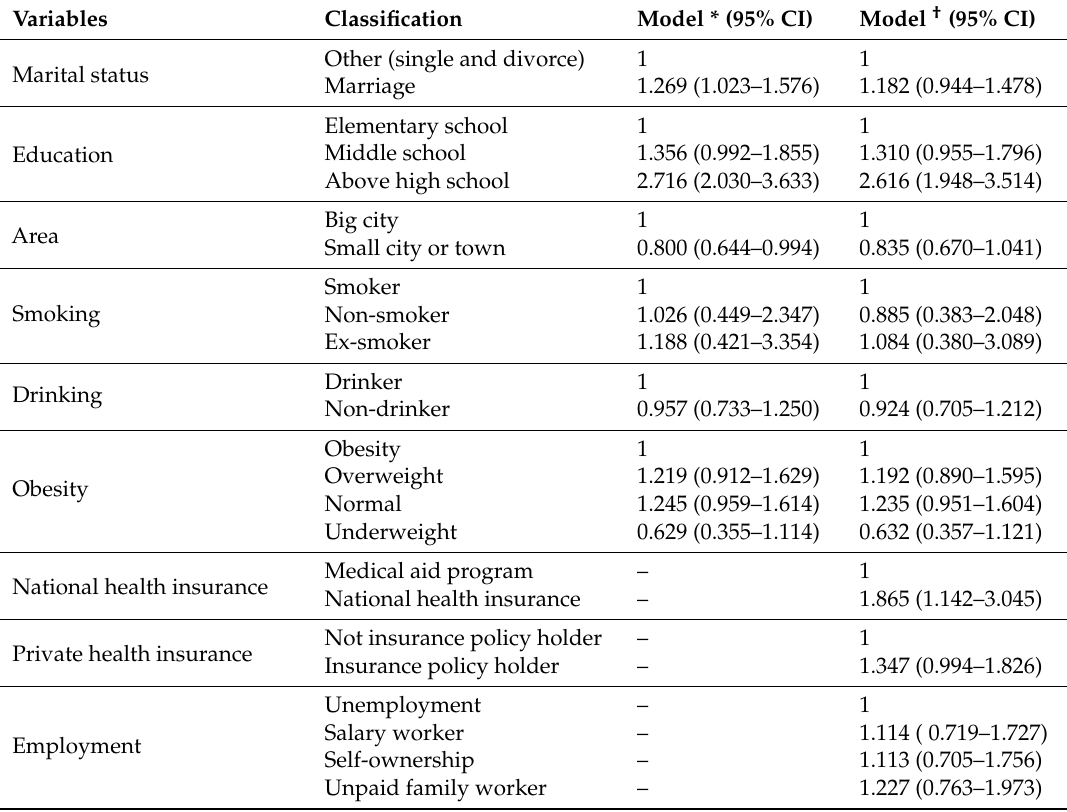
Table 4. Subjective health status of females aged 65 years and